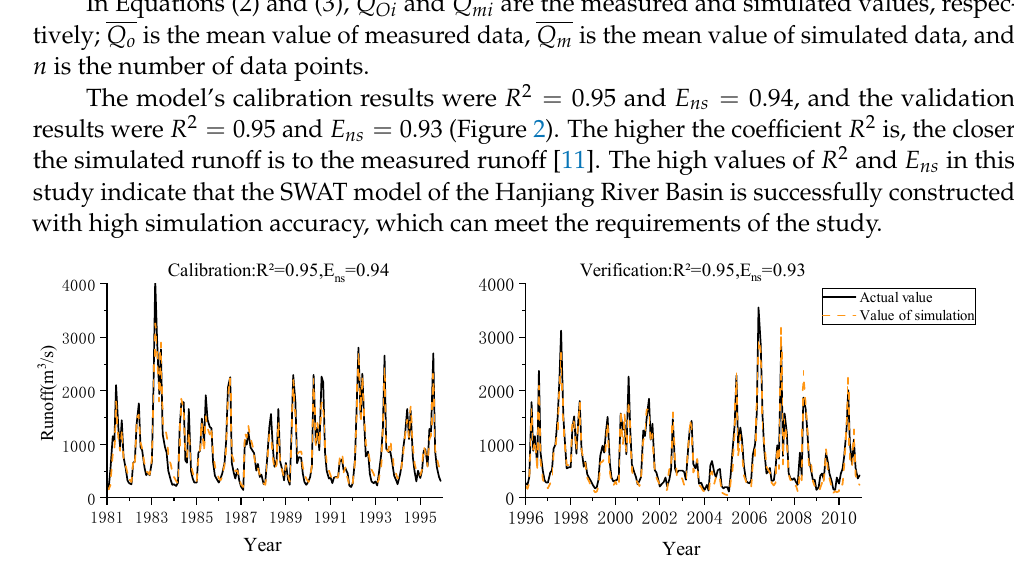
Figure 2. Simulated runoff and measured runoff for model rate determination and validation.